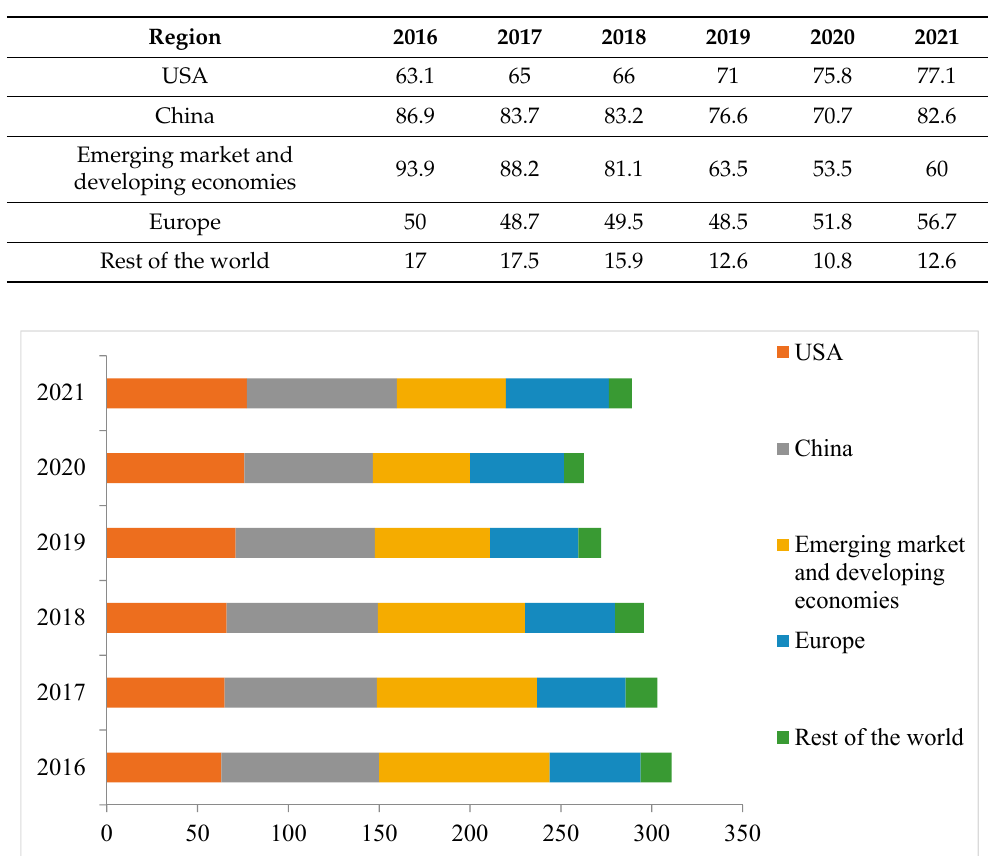
Figure 9. Investment spending in electricity networks by region.